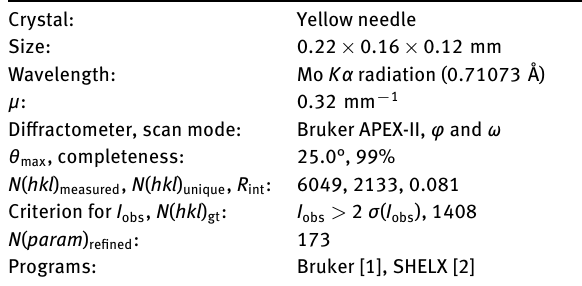
Table 2: Fractional atomic coordinates and isotropic or equivalent isotropic displacement parameters (Å 2 ).